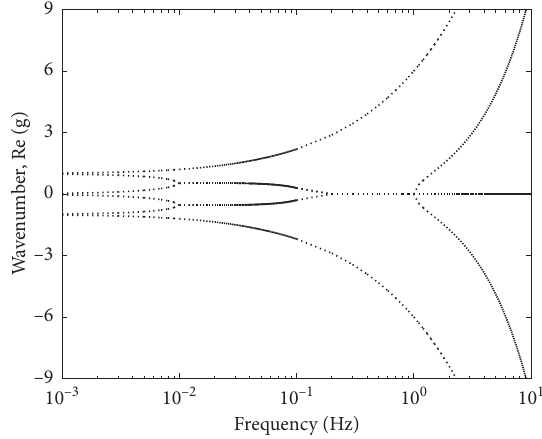
Figure 4: Frequency spectra (by Lee).